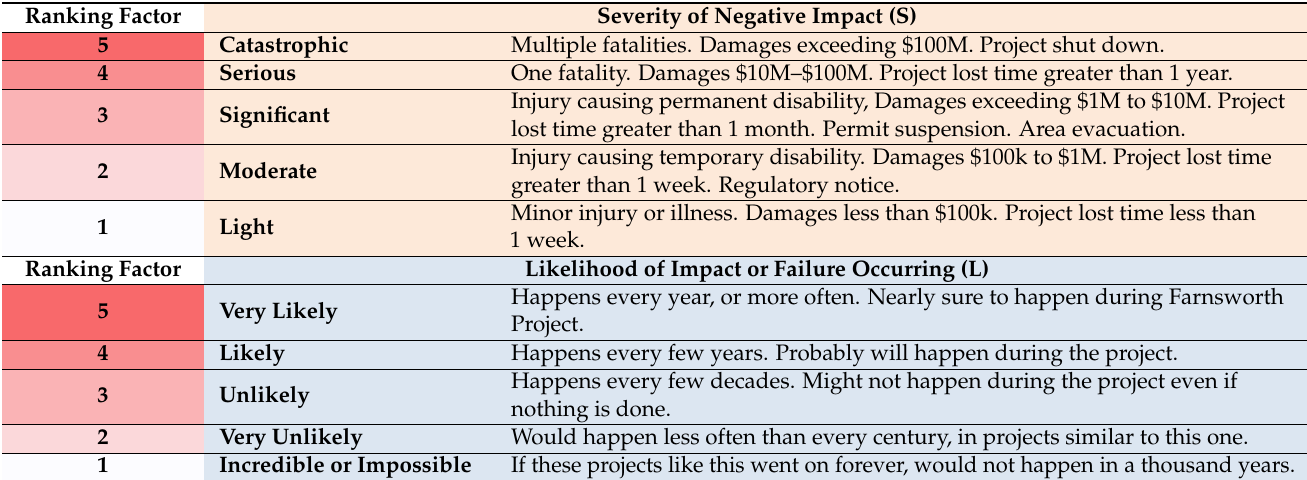
Table 1. Severity and likelihood